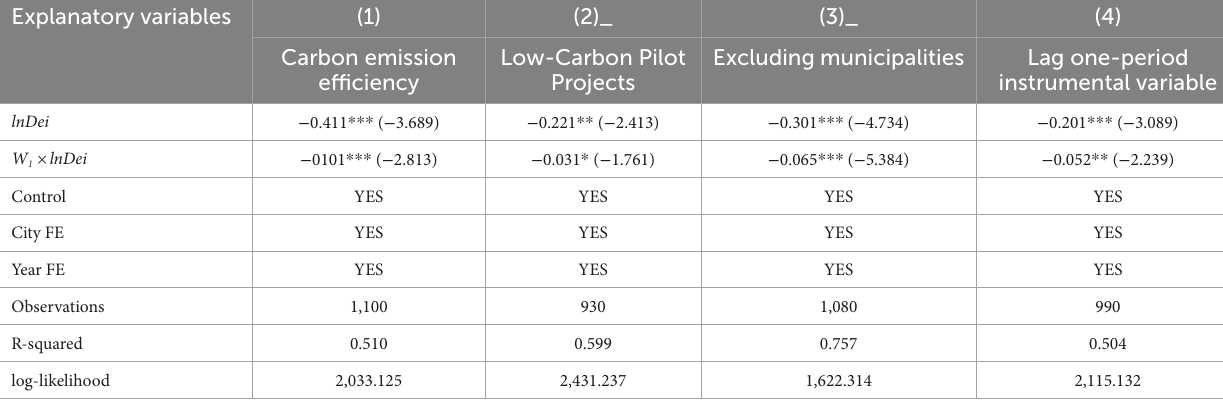
TABLE 11 The regression results of the robustness